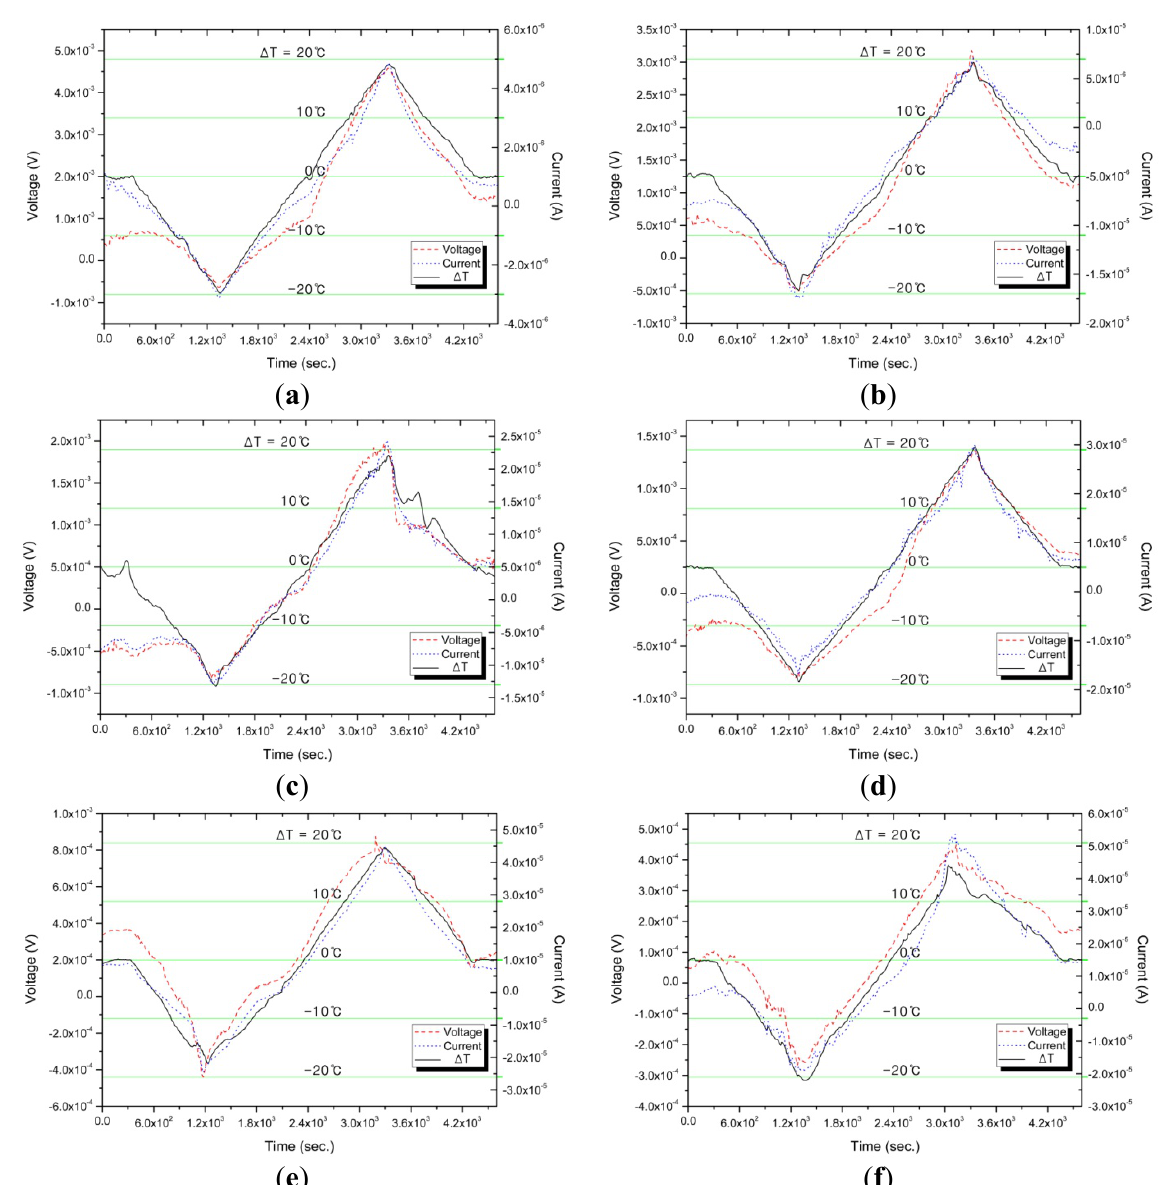
Figure 4. Thermoelectric characteristics due to Δ T variation for ( a ) 0.5; ( b ) 1.0; ( c )